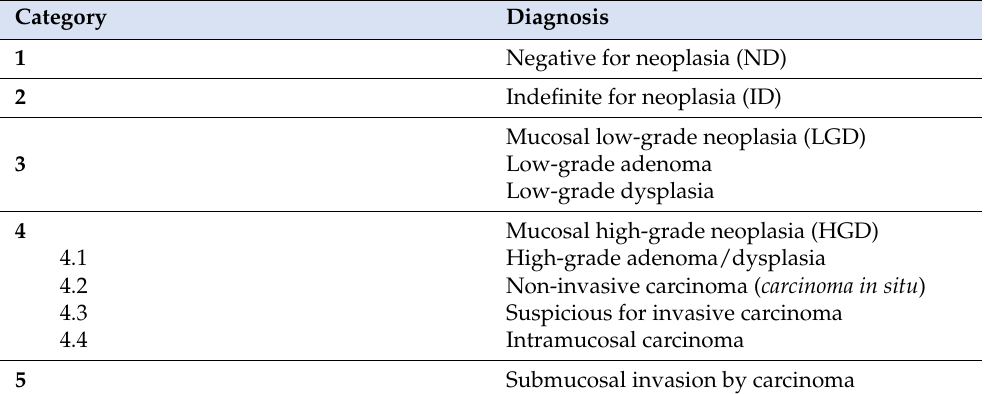
Table 1. Revised Vienna Classification.